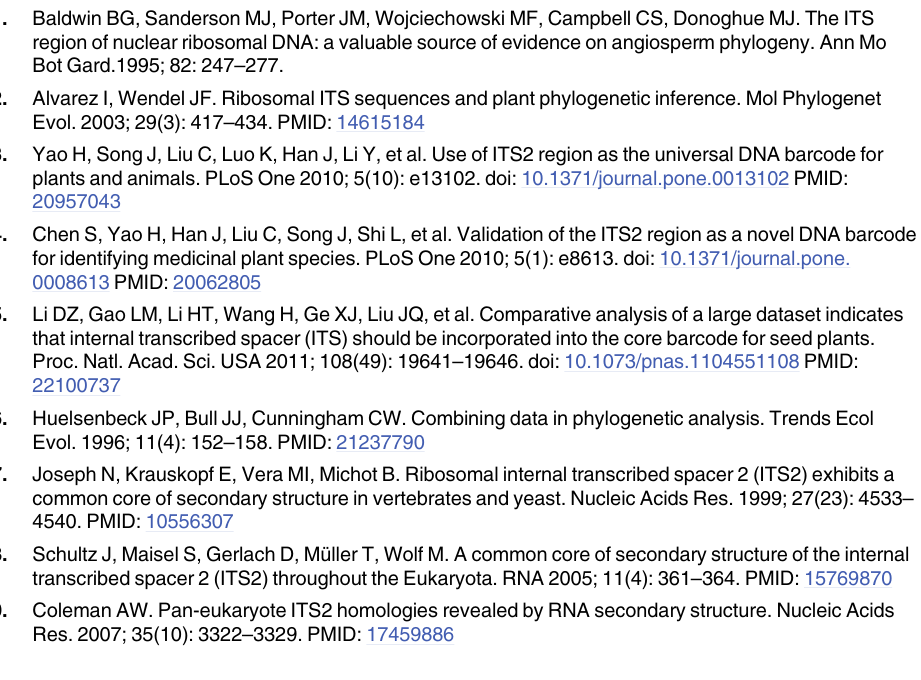
S1 Fig. Structure of the ITS region of the nuclear ribosomal RNA genes and schematic loca- tion of primer used in this study. “ ITS4 ” = TCCTCCGCTTATTGATATGC ; “ ITS5 ” = GGAAG- TAAAAGTCGTAACAAGG . (Modified from Baldwin BG, 1995).